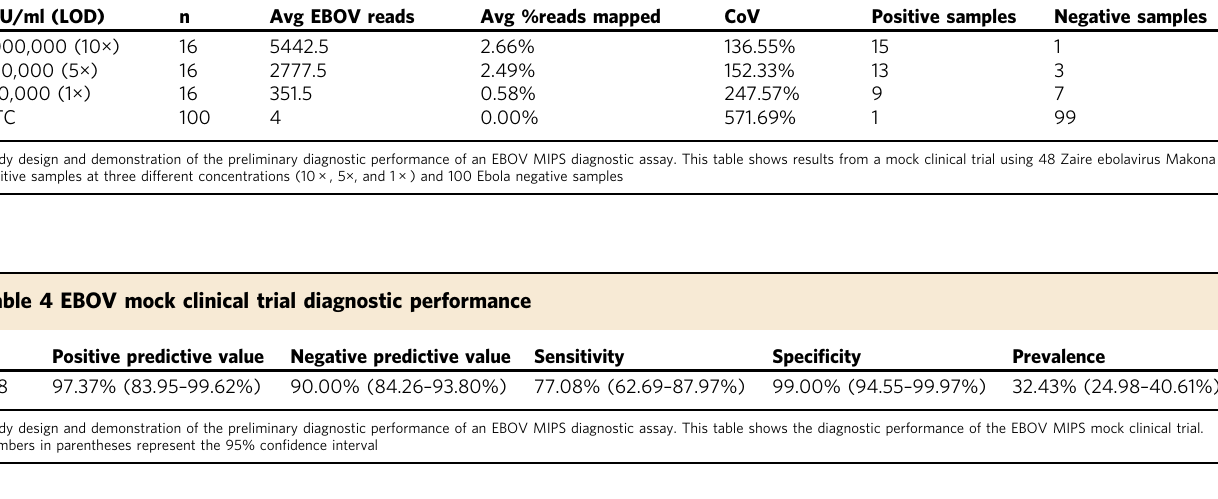
Table 3 Experimental design and results from EBOV mock clinical trial PFU/ml (LOD)